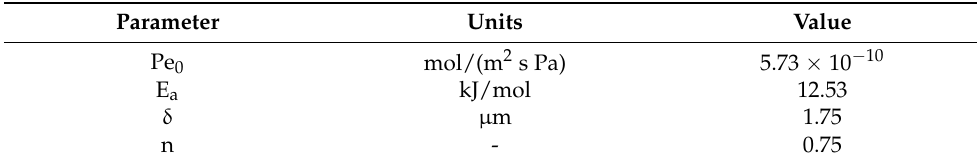
Table 1. Permeability parameters for the Pd–Ag membrane used in this work.